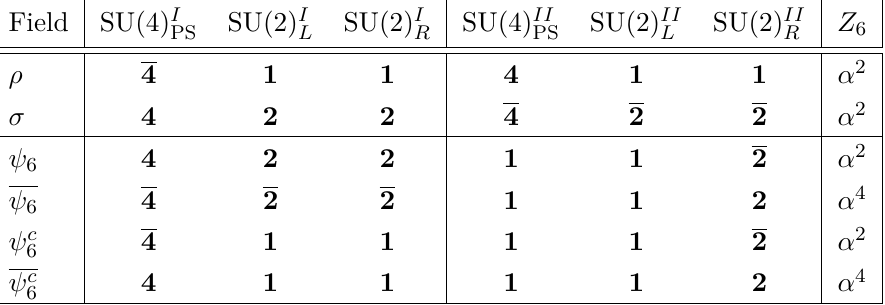
Table 4 . The additional fields which replace the personal Higgs H, H in table 1. All the other fields are required above the double lines in table